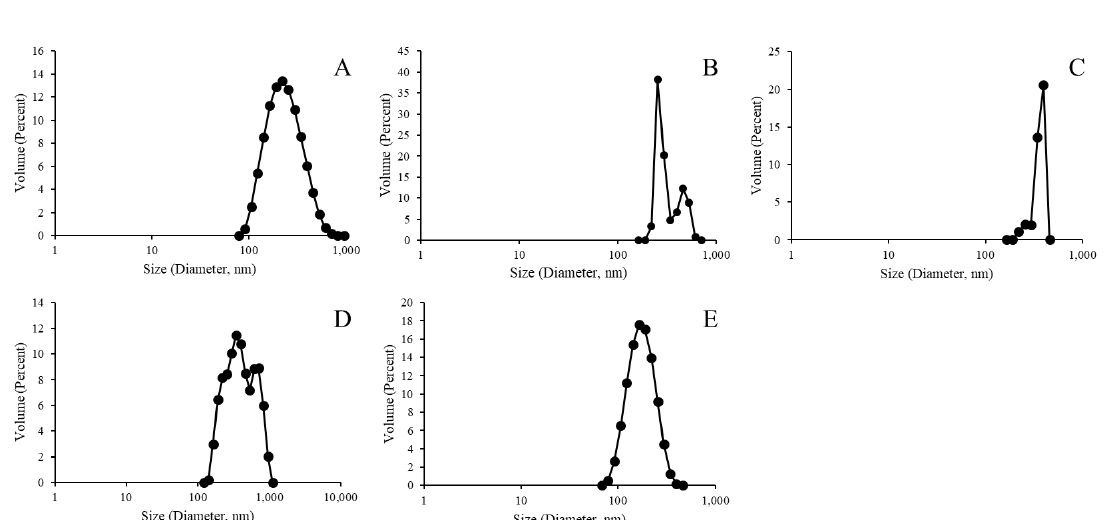
Figure 7. Size distribution analysis of polysaccharide 19F encapsulated green fluorescent protein (GFP)-bound liposomes without metallic binding element (( A ) PDI: 0.17), and with Ni (( B ) PDI: 0.25), Co (( C ) PDI: 0.74), Zn (( D ) PDI: 0.79), and biotinylation (( E ) PDI: 0.34).